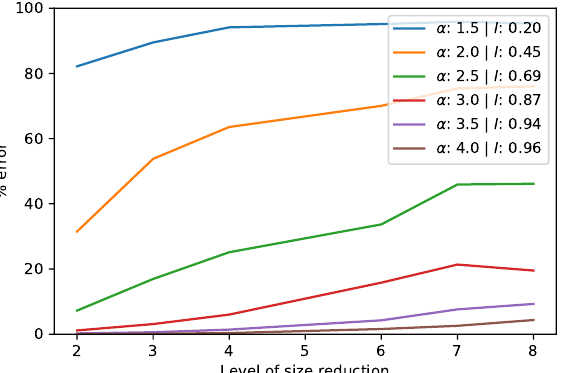
Figure 11. Error in the SVD of the product of two reduced fields for various α